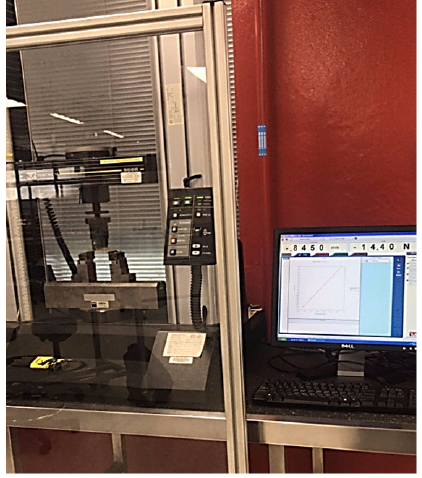
Figure 9. Photograph of the flexural test by using the Instron© 5566. Multiple flexural tests were carried out using GFRE samples, as shown in Figure 10. Similarly, SFRE was also tested as shown in Figure 11. The data were collected and the mean values were taken for further